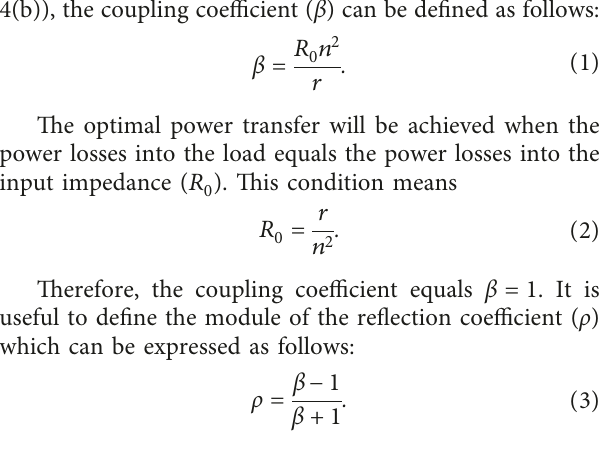
tion Diagram. From the equivalent electrical circuit (Figure